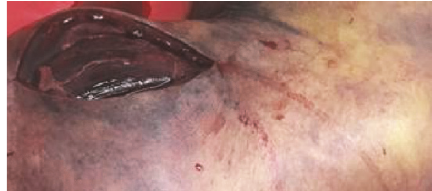
Figure 2: Intraoperative photograph showing nonviable tissue from incision made over the biceps